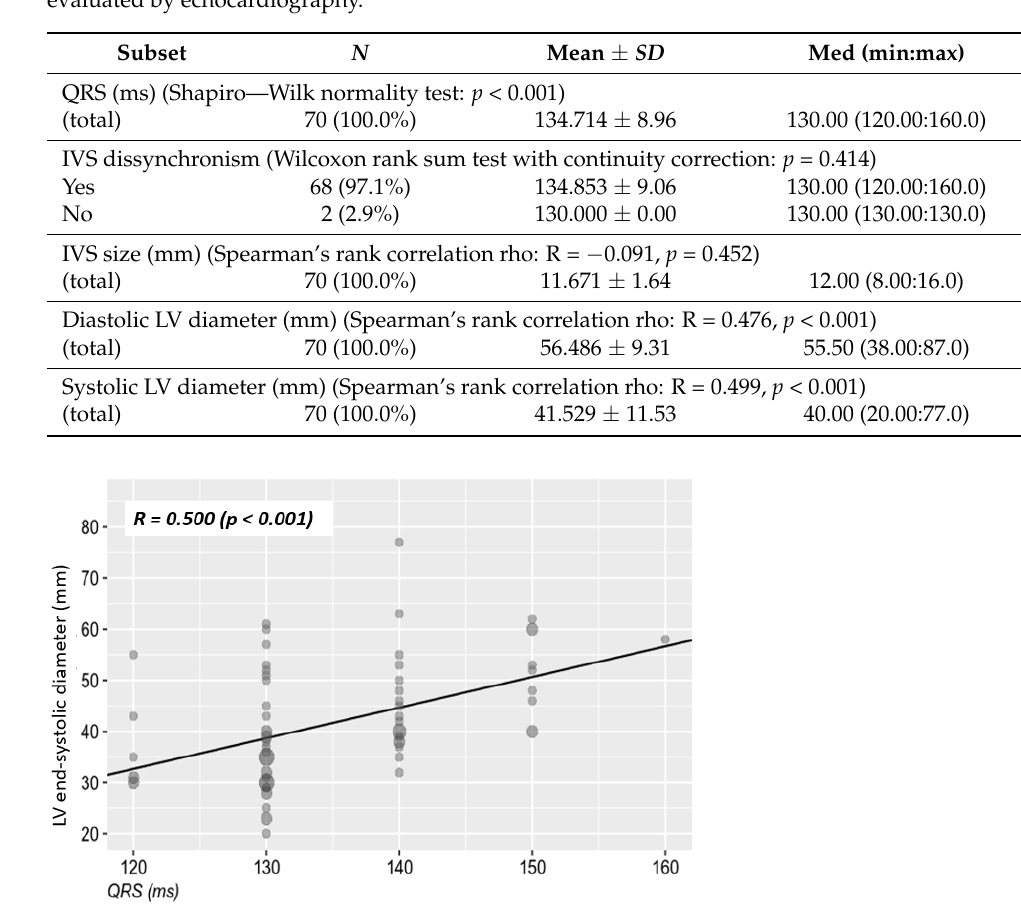
Table 4. The correlation between the presence of LBBB, its duration, and the structural changes of LV evaluated by echocardiography.